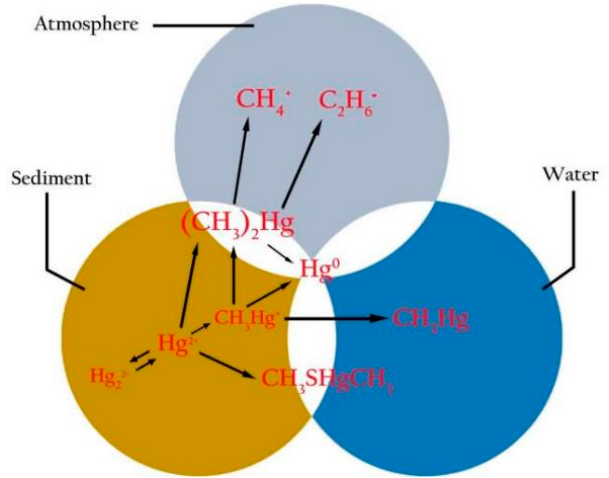
Figure 1. Existing forms and transformation of elemental, inorganic and organic mercury (Hg) in sediment, water and atmosphere.